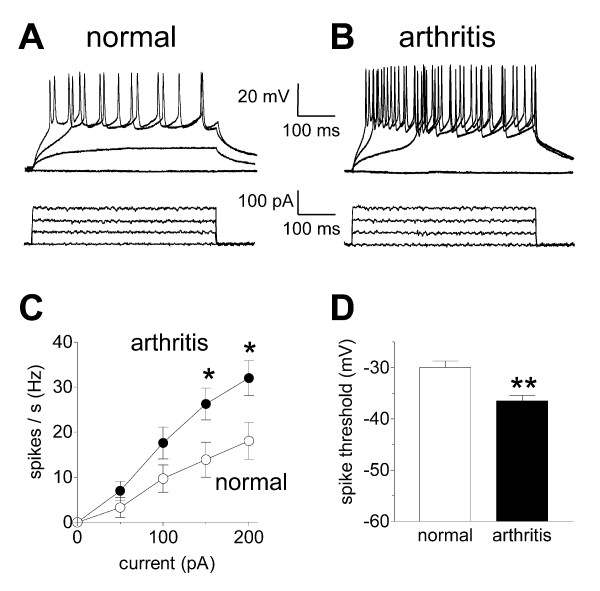
Increased excitability of SG neurons in the arthritis pain model. Increased action potential firing rates and decreased thresholds for action potentials were recorded in SG neurons in slices from arthritic rats compared to controls. A, B, Current-clamp recordings of action potentials (spikes) generated by direct intracellular injections of depolarizing current pulses of increasing magnitude (0 to 200 pA; 500 ms) in an SG neuron from a normal animal (A) and in an SG neuron from an arthritic animal (B). C, Analysis of the input-output relationships shows significantly increased spike frequency in arthritis (n = 13 neurons) compared to control (n = 25 neurons; P < 0.05; two-way ANOVA followed by Bonferroni posttests). D, Significantly decreased spike thresholds (membrane potentials at which action potential firing started) were recorded in SG neurons in arthritis (n = 11) compared to control neurons (n = 17; P < 0.01; unpaired t-test). * P < 0.05, ** P < 0.01.